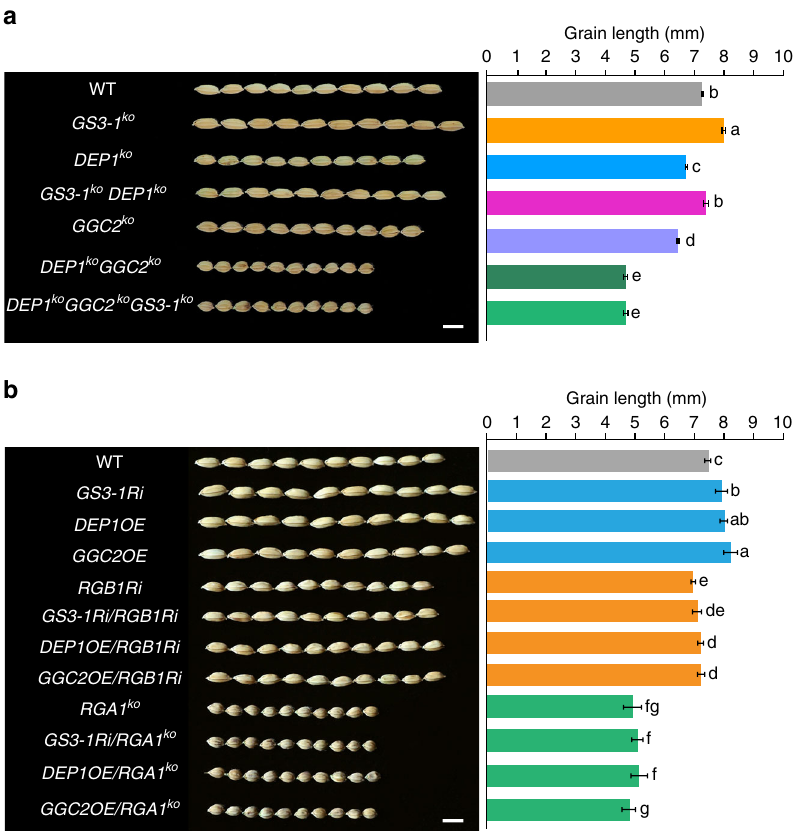
Fig. 2 Genetic interactions of three G γ proteins and G β or G α proteins. a Genetic interactions of DEP1 , GGC2 , and GS3 . Grains and grain length of WT (wild type ZH11) ( n = 10), single mutants of GS3-1 ko ( n = 13), DEP1 ko ( n = 13), and GGC2 ko ( n = 13), double mutants of GS3-1 ko DEP1 ko ( n = 10) and DEP1 ko GGC2 ko ( n = 5), and triple mutant of DEP1 ko GGC2 ko GS3-1 ko ( n = 5). The data shown are mean ± SEM. Different letters indicate signi fi cant differences ranked by the Fisher ’ s Least Signi fi cant Difference (LSD) test ( P < 0.05). Bar = 5 mm. b Genetic interactions of the G γ proteins with RGA1 and RGB1. Grains and grain length of WT, GS3-1Ri , DEP1OE , GGC2OE , and their hybrids with RGB1Ri and RGA1 ko , respectively. Values are given as mean ± SEM. Different letters indicate signi fi cant differences ranked by the LSD test ( P < 0.05). Bar = 5